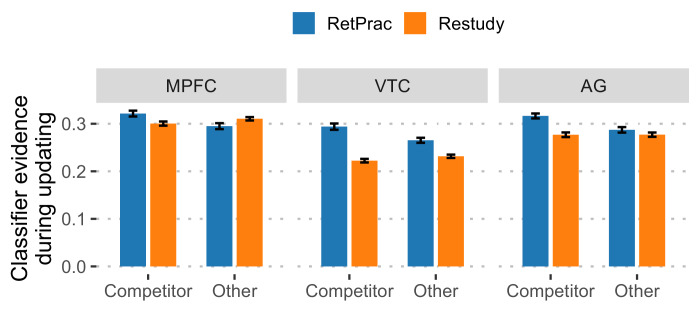
Classifier evidence of competitor and 'other' categories for correct trials during the A-C updating phase.A similar pattern was found when only correct (target) trials were included. There was greater competitor than 'other' evidence under the RetPrac condition (all p-values <0.017), but comparable levels of evidence under the Restudy condition (all p-values >0.07). Direct comparisons also revealed significantly stronger competitor reactivation under the RetPrac than under the Restudy condition in all regions (all p-values <0.005).